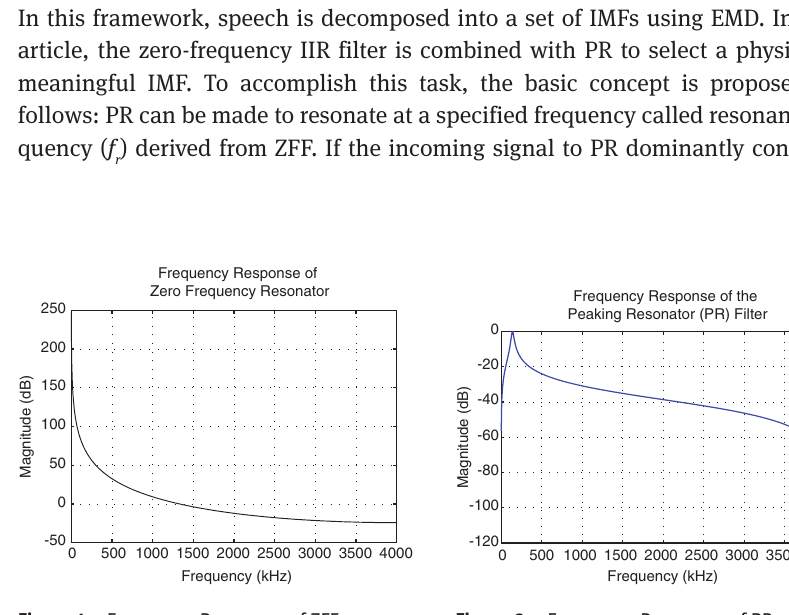
Figure 1. Frequency Response of ZFF. Figure 2. Frequency Response of